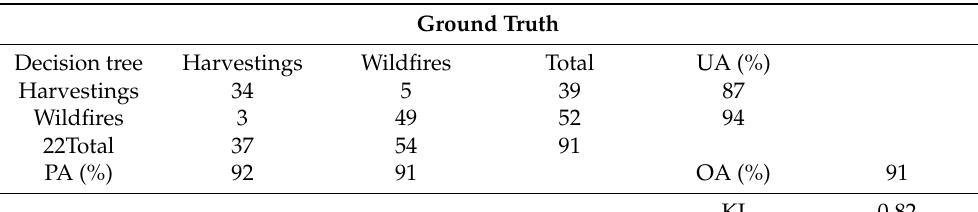
Table 4. Confusion matrix resulting from the application of the decision tree that classifies distur- bances according to their drivers (wildfires or harvesting) to the test set of data. PA: Producer’s Accuracy; UA: User’s Accuracy; OA: Overall Accuracy; KI: Kappa Index. Ground Truth Decision